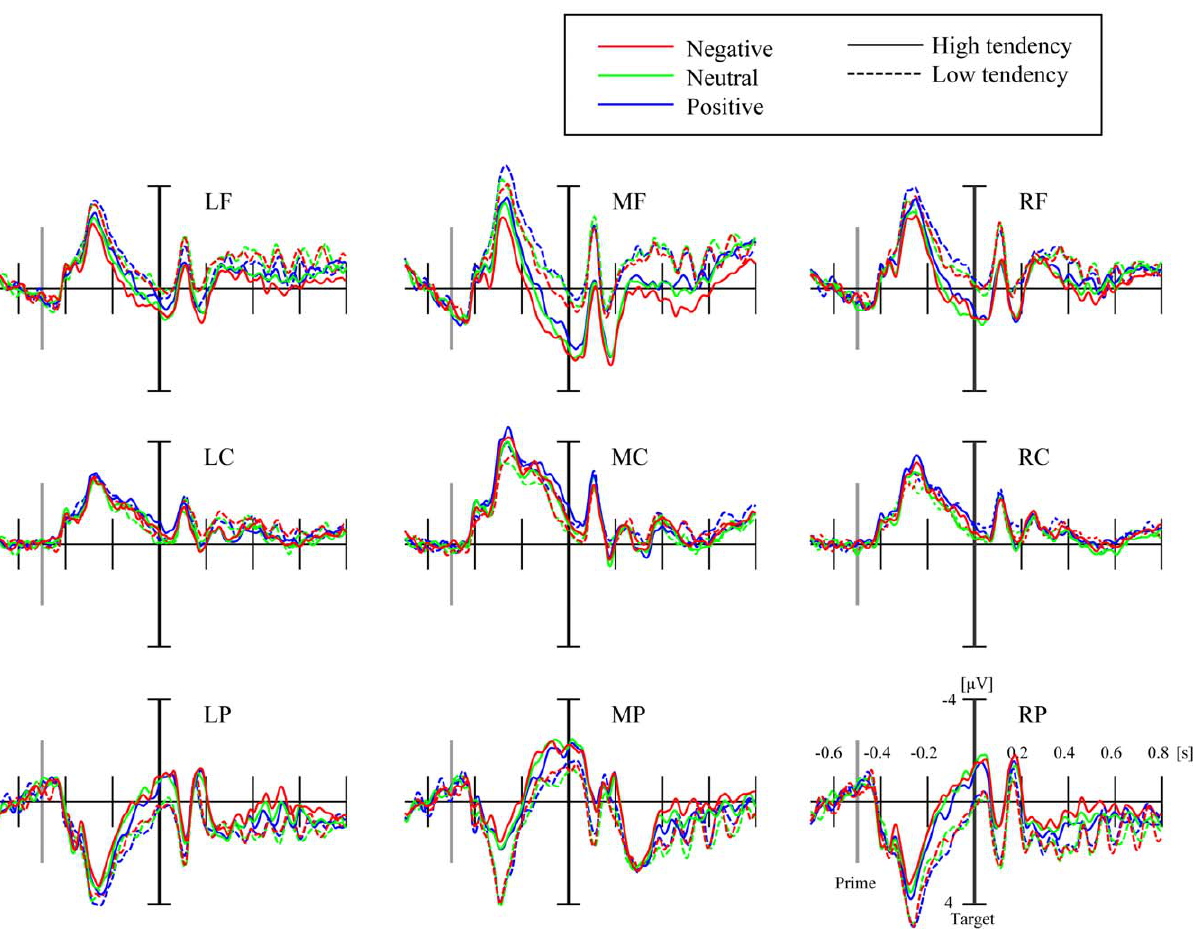
Figure 4. Grand-averaged ERPs in the 9 clusters for prime valence (negative, neutral, and positive) and misattribution tendency (high, low).